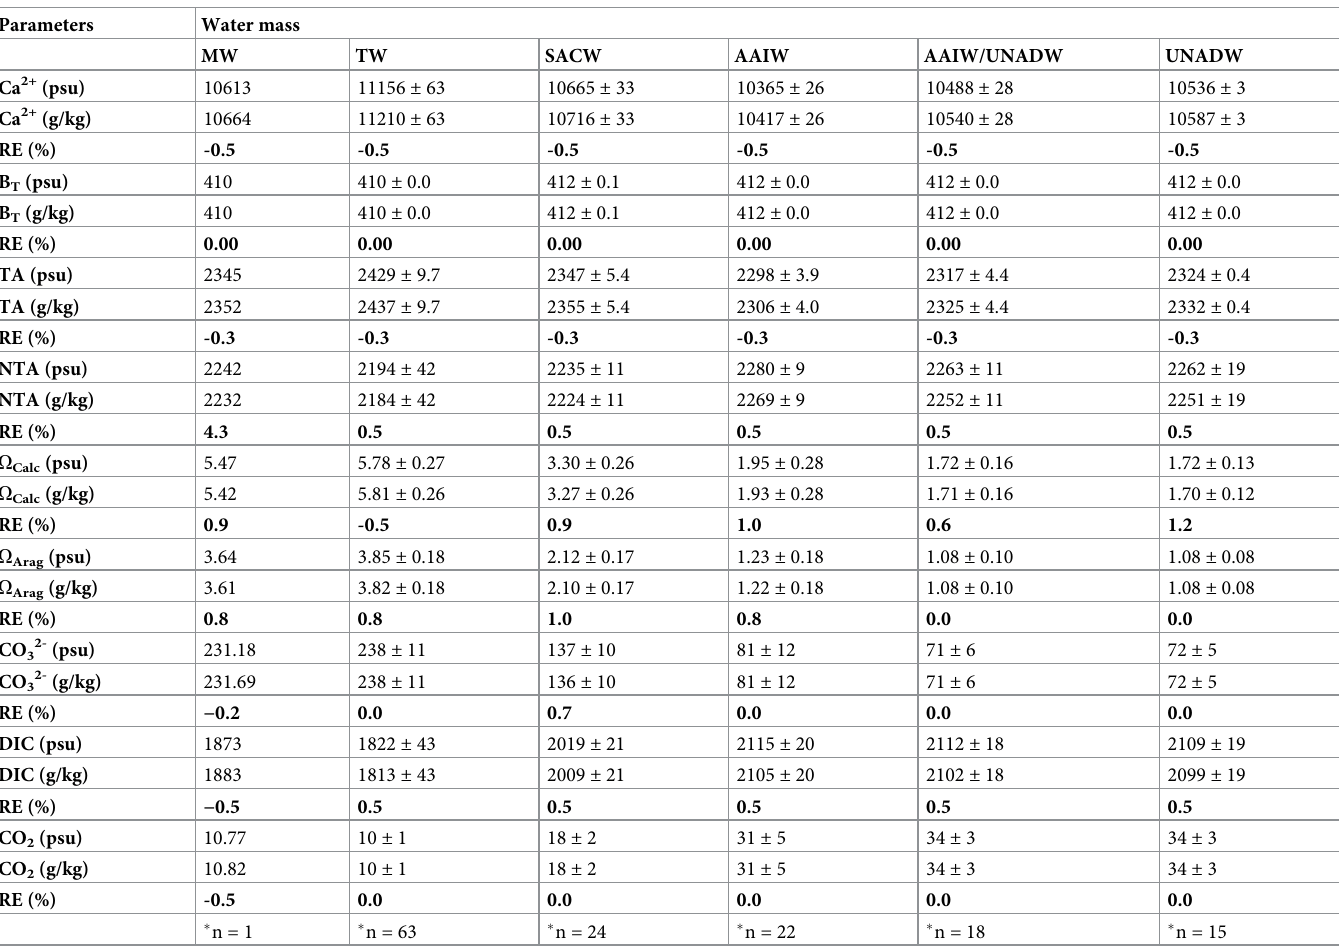
Table 7. Effects of the practical (psu) and absolute salinity (g/kg) scales when generating the carbonate system parameters. Values obtained from calculated total alkalinity with the AQM program [1, 13–15]. Further information can be found in the methodology section. In calculating the relative error (RE%), the parameters obtained by the absolute salinity (g/kg) are the expected values.